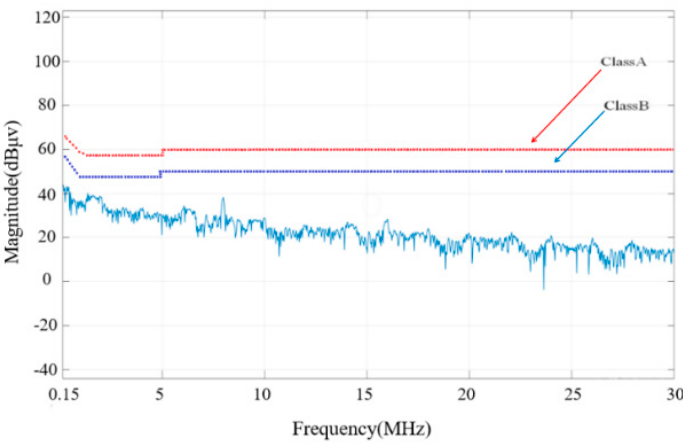
Figure 26. CM voltage of three-phase four-leg rectifier under the jump-backward control strategy.